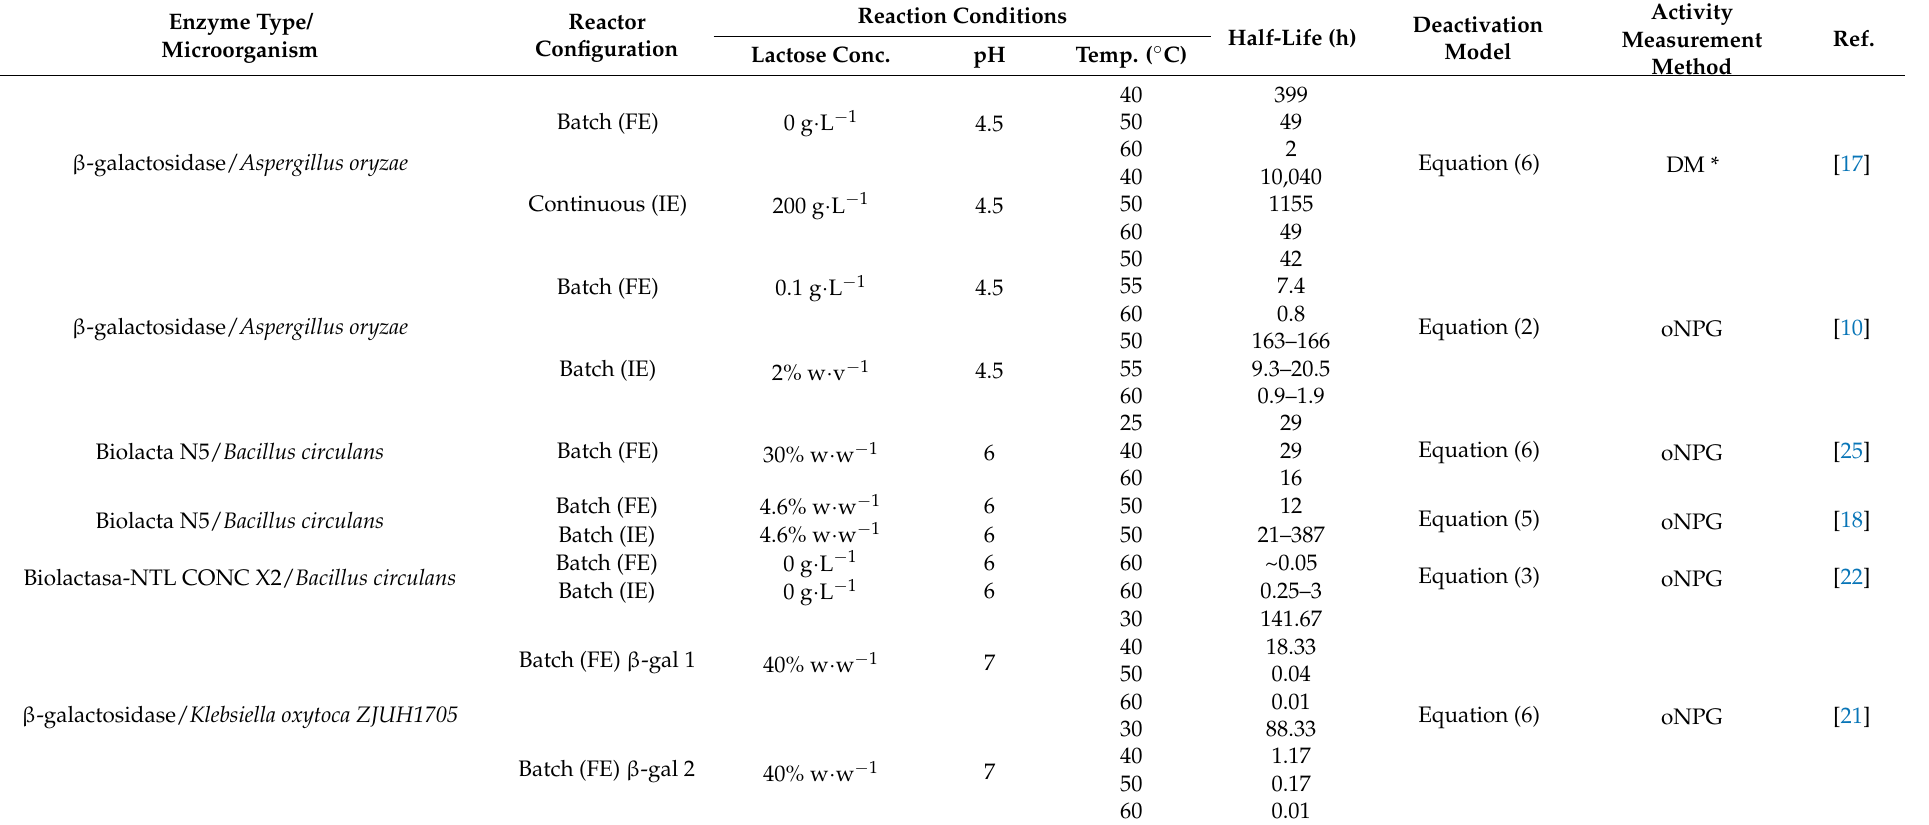
Table 1. Summary of investigations on enzyme stability of β -galactosidases in GOS